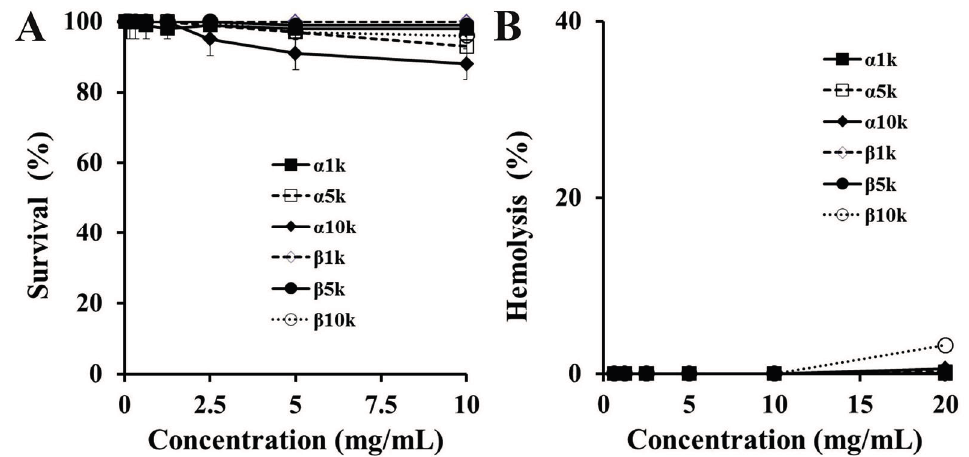
Figure 1. Cytotoxic and hemolytic effects of α -chitosan and β -chitosan samples against HaCaT cells ( A ) and rRBC ( B ), respectively. ( A ) HaCaT cells were exposed for 24 h to different concentrations of samples and percentage of cell survival was determined by the MTT (3-(4,5-dimethylthiazol-2-yl)-2,5diphenyltetrazolium bromide) assay; ( B ) Dose-dependent hemoglobin release activity was measured after 1 h of incubation with rat erythrocytes (8% hematocrit). All graphs represent the mean ± S.E.M. of values obtained from at least two independent experiments performed in